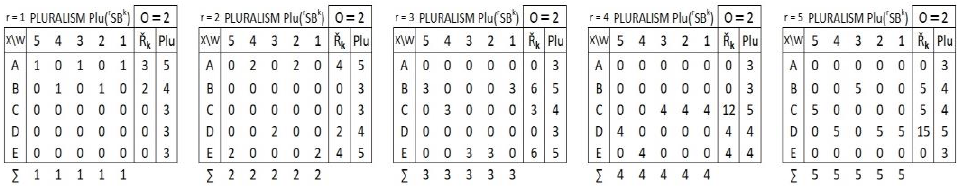
Figure 7. Comparison of the voting procedures, r SB k weight submatrix where “r = 1, . . . , 5”. To obtain the pluralism ranking aggregation as shown in Figure 6, Ř k is the column (vector) of the maximum values of each row (or alternative) in the SP k matrix, where Plura represents the preference order assigned to the candidates.